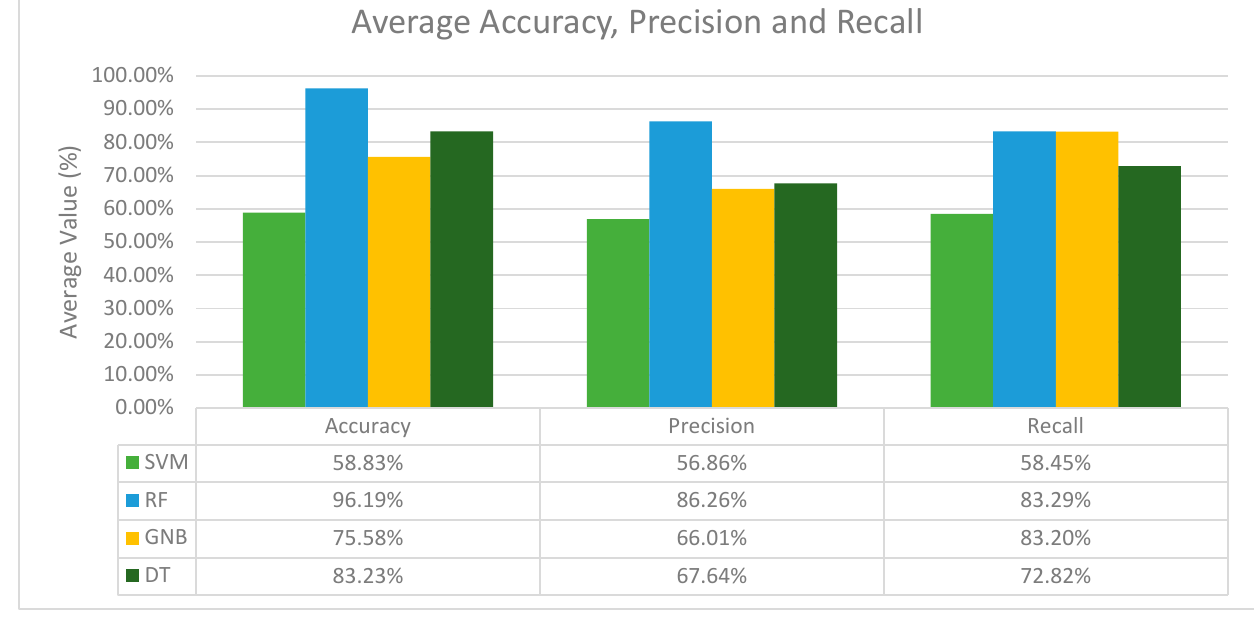
Figure 1. Average accuracy, precision and recall of all machine learning classifiers in general.